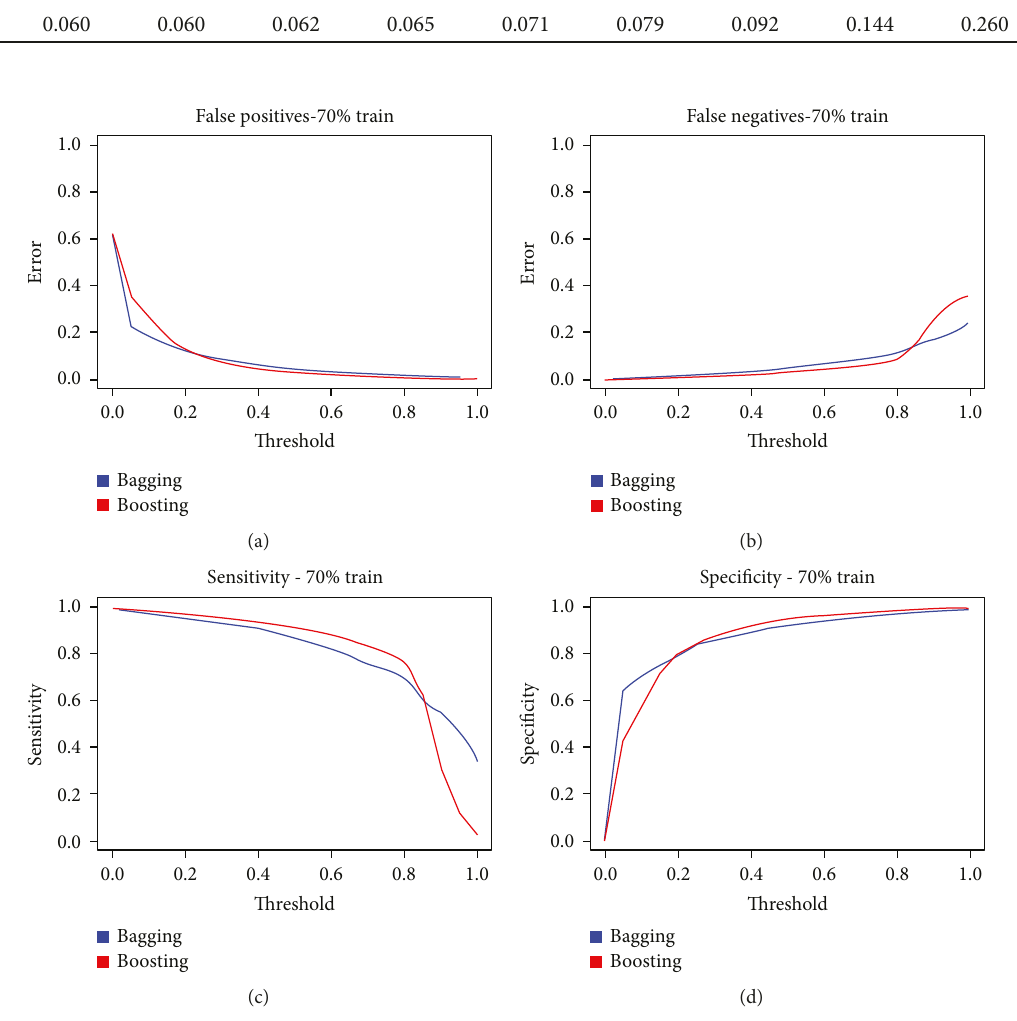
Figure 3: False positives, false negatives, speci fi city, and